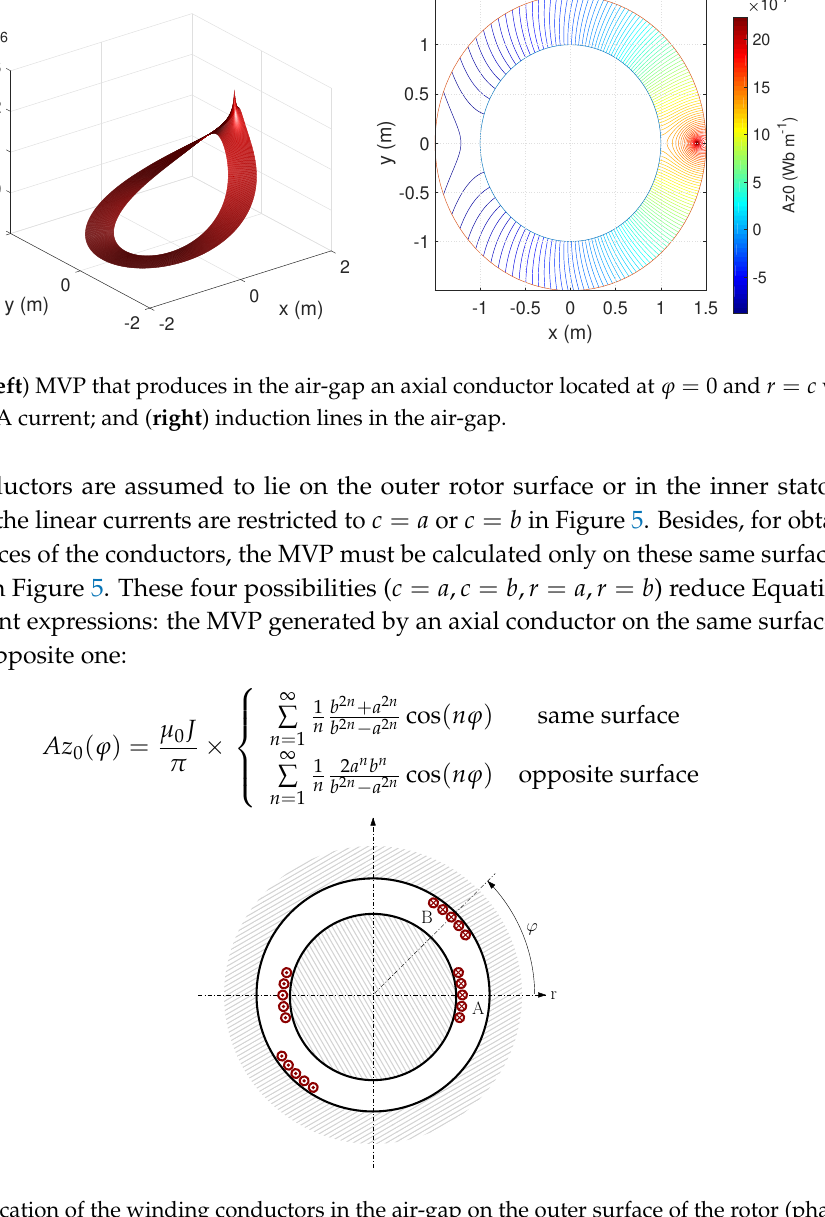
Figure 5. Location of the winding conductors in the air-gap on the outer surface of the rotor (phase A ) and on the inner surface of the stator (phase B ), for two phases separated an angular distance ϕ